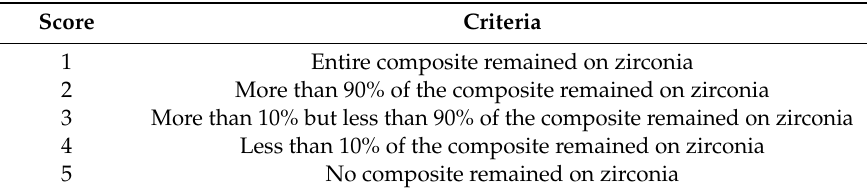
Table 2. Criteria of modified adhesive remnant index (ARI) scores. Score Criteria 1 Entire composite remained on zirconia 2 More than 90% of the composite remained on zirconia More than 10% but less than 90% of the composite remained on zirconia Less than 10% of the composite remained on zirconia No composite remained on zirconia